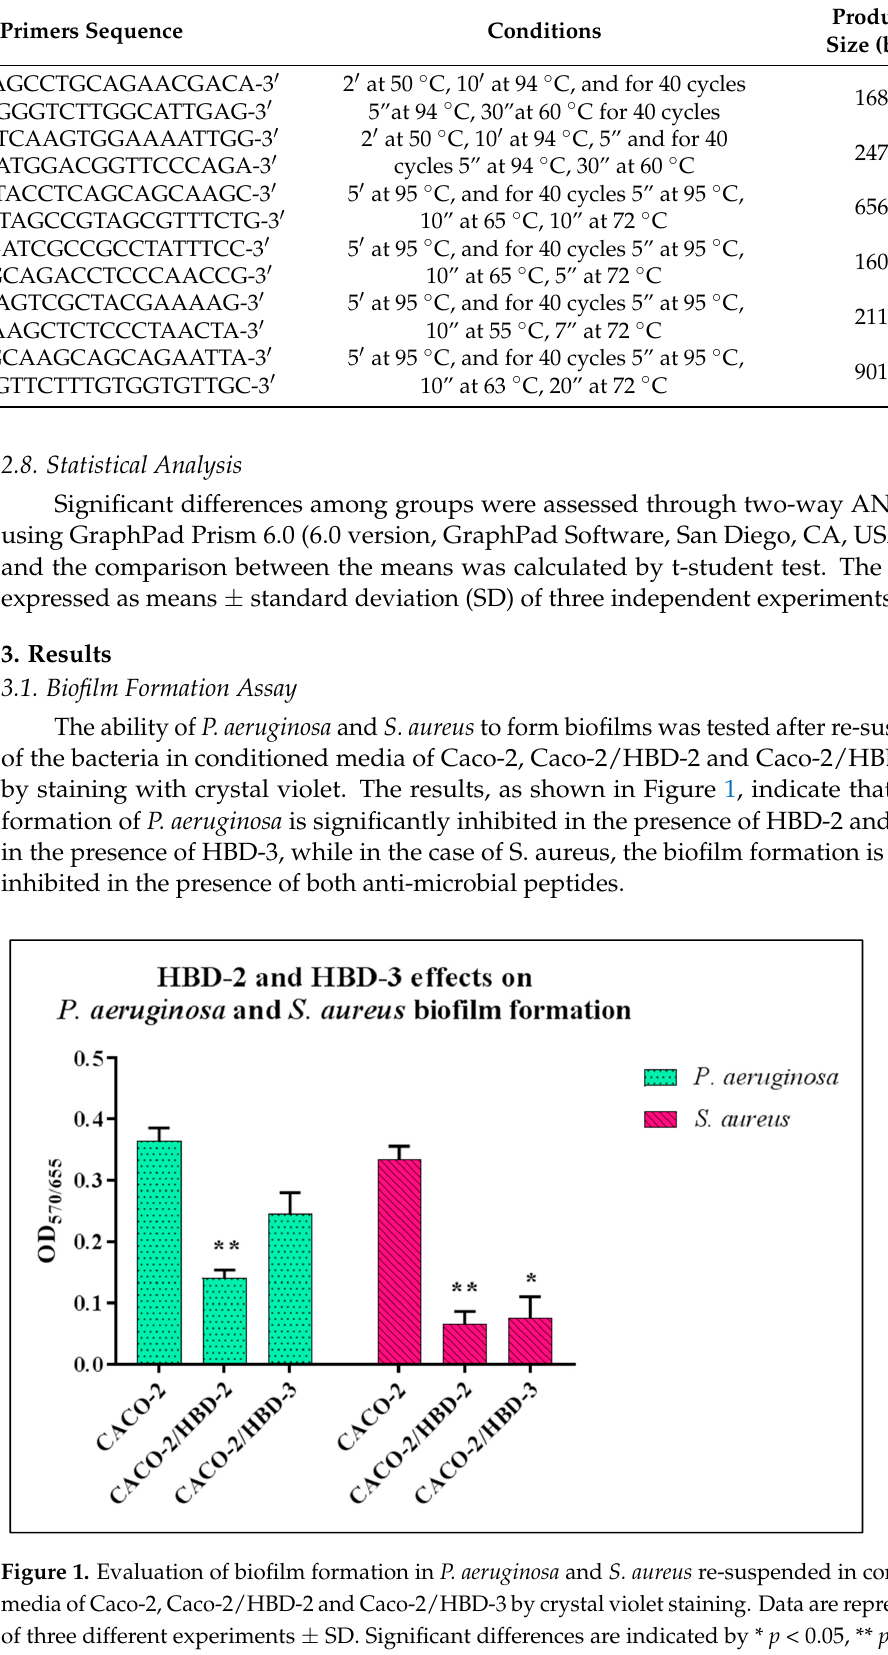
Table 1. Primer sequences and amplification programs used in this work.